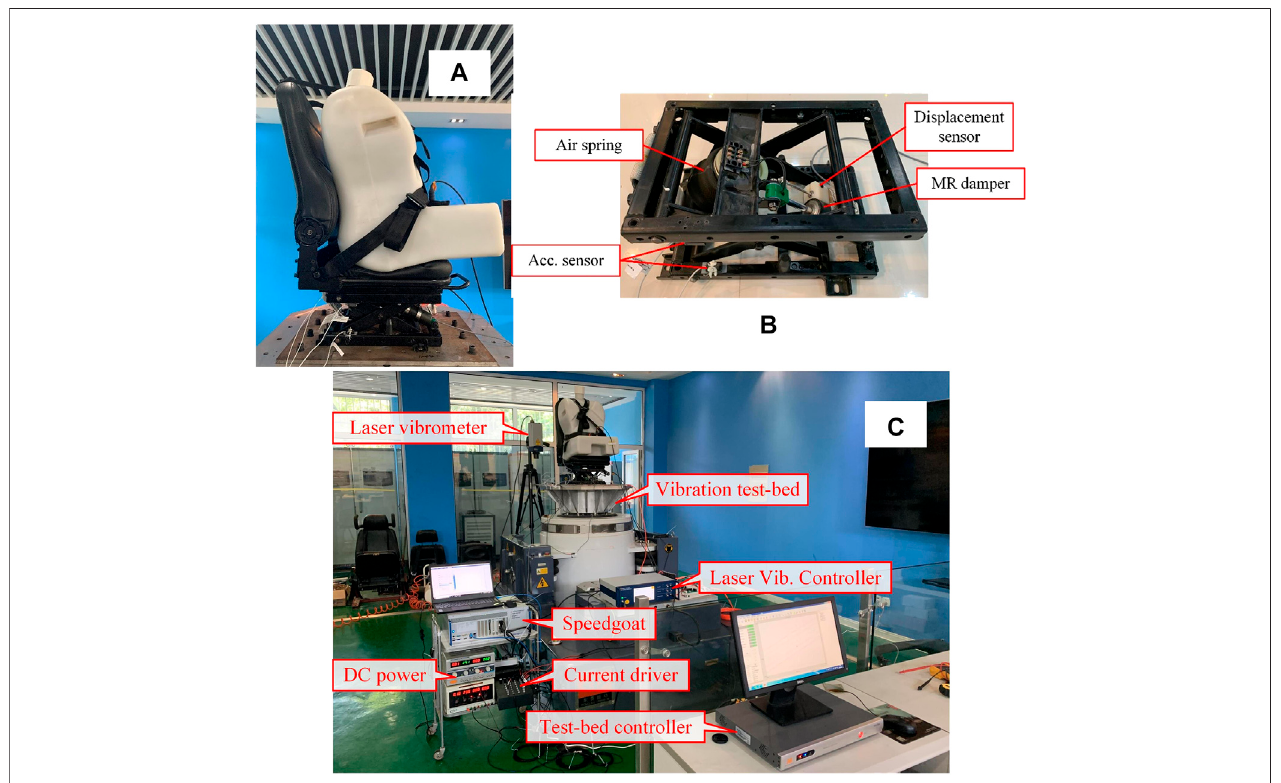
FIGURE1 | The structure ofthe scissors-linkage seat suspensionand experiment setup: (A) seat photo; (B) the structure ofthe scissors-linkage seat suspension; (C) the experiment setup.